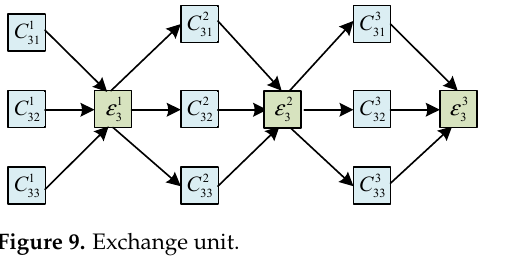
Figure 10. Feature maps of different resolutions undergo upsampling or downsampling to fuse cross-scale information always to maintain the high resolution of the feature maps and supplement the high-resolution features multiple times.